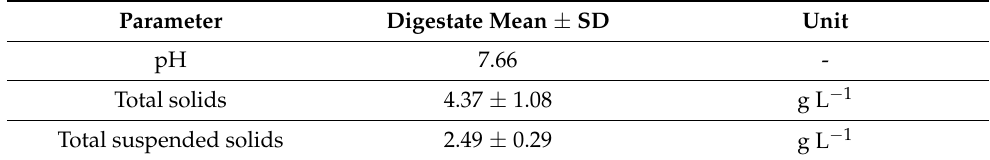
Table 2. Characteristics of the raw